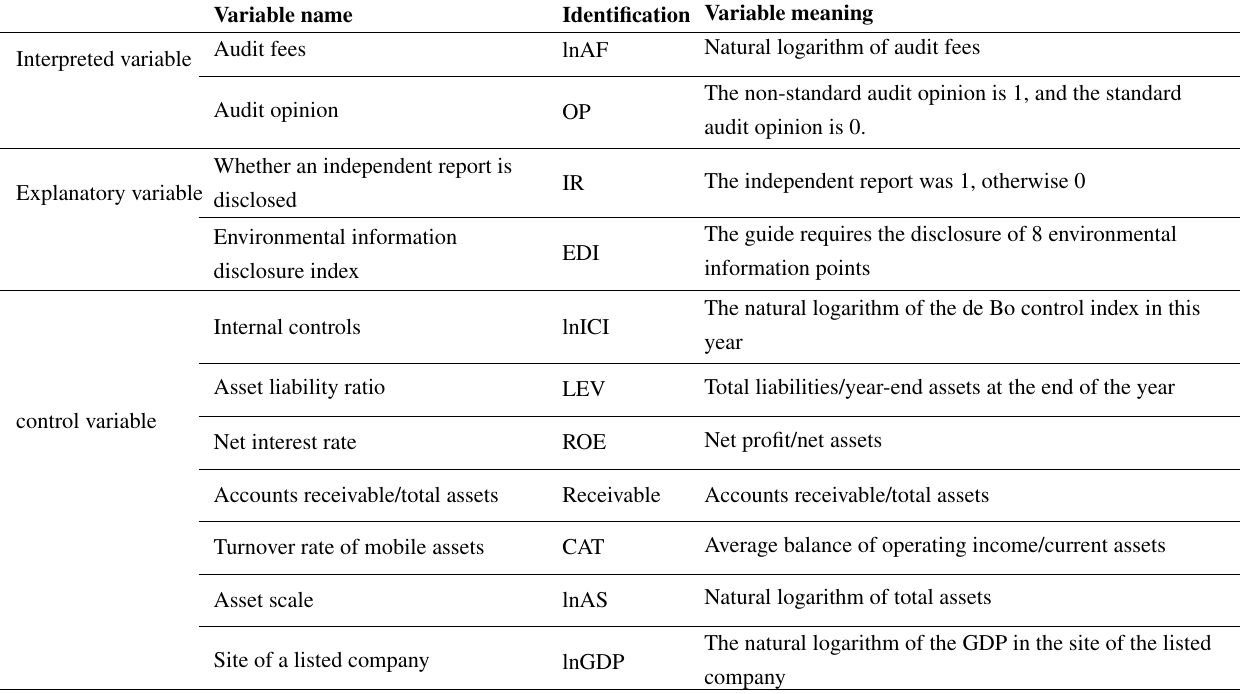
Table 1 Variable summary